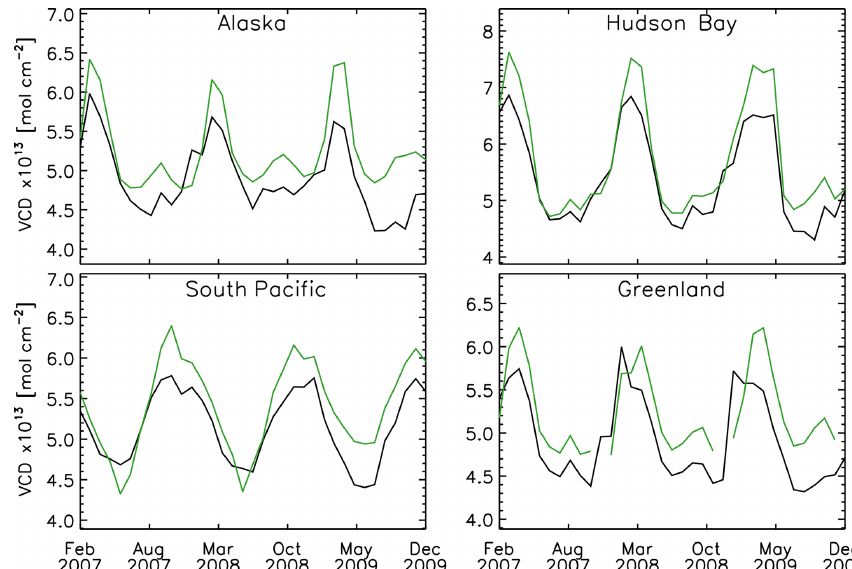
Figure 7. VCD of GOME-2 (green) comparison to OMI (black) over four regions from February 2007 to December 2009 for four regions. Each region is defined by a square with the following latitude and longitude boundaries: Alaska (50–70 ◦ N, 165–135 ◦ W), Hudson Bay (50–65 ◦ N, 95–75 ◦ W), the South Pacific (70–50 ◦ S, 135–155 ◦ E) and Greenland (60–80 ◦ N, 60–15 ◦ W).